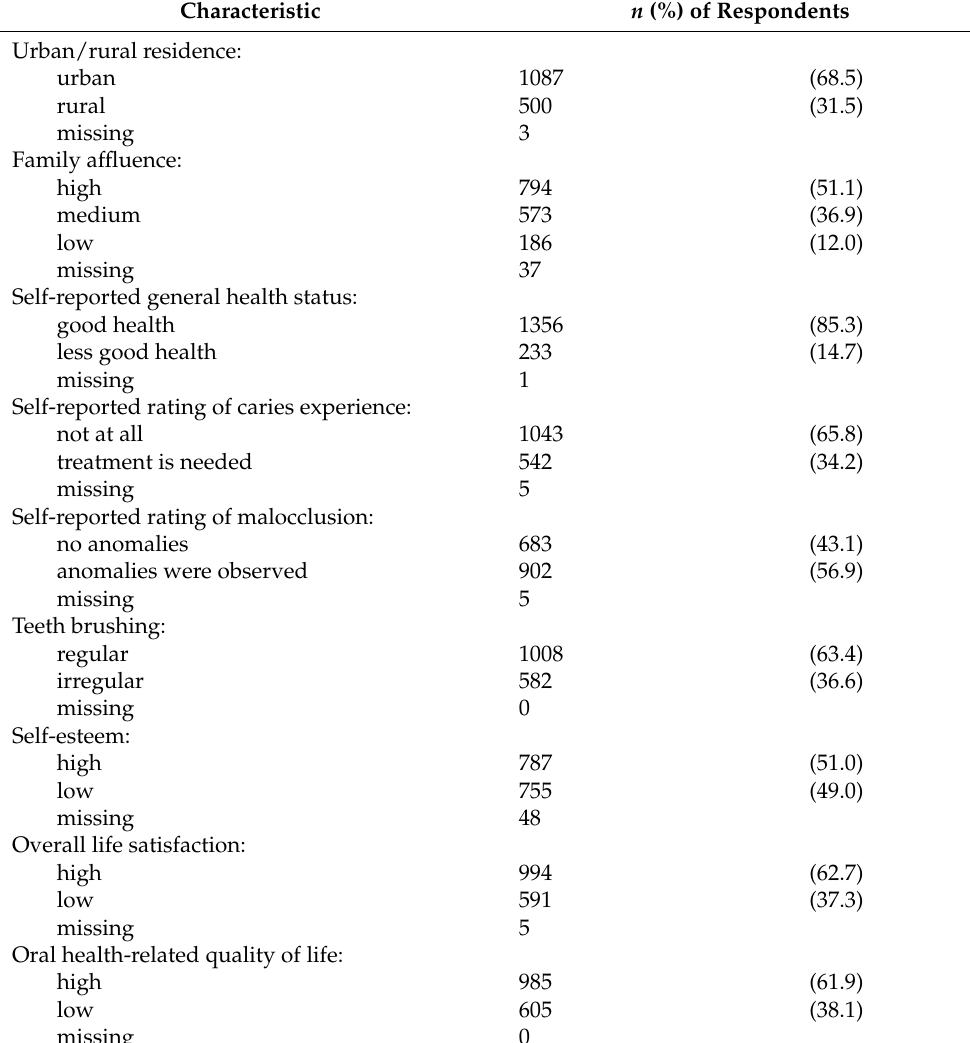
Table 2. Sample characteristics reported by the students ( n =